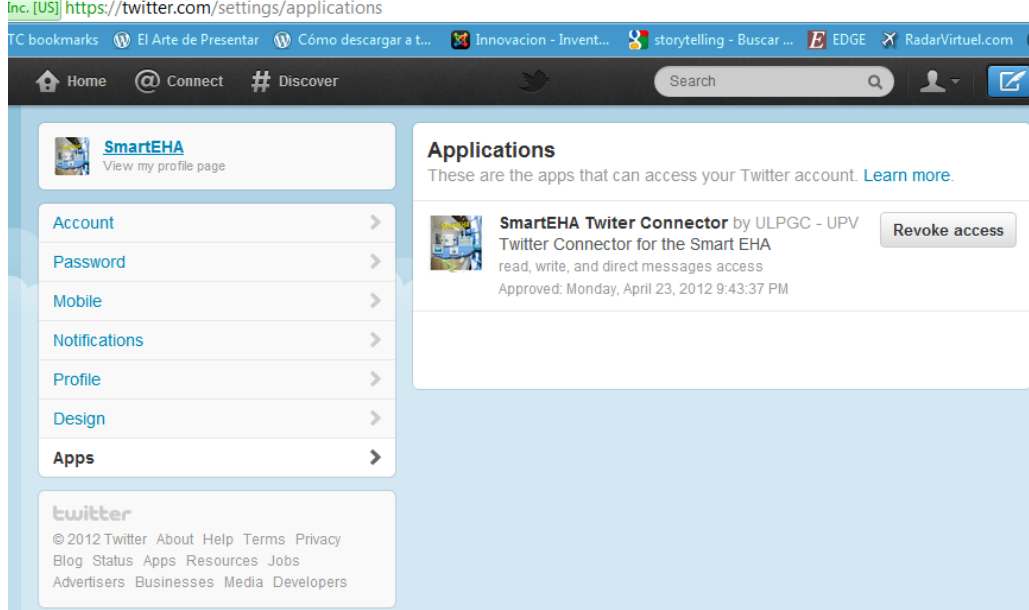
Figure 11. Twitter connector application for SmartEHA.